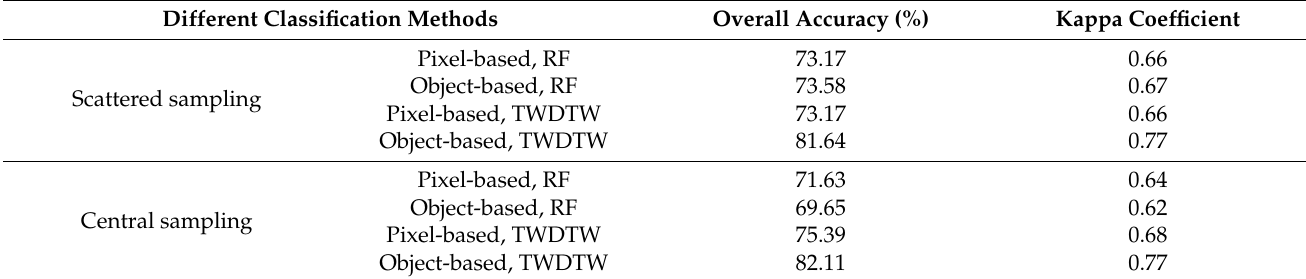
Table 1. Overall accuracies and Kappa coefficients under different sampling strategies, perspectives, and